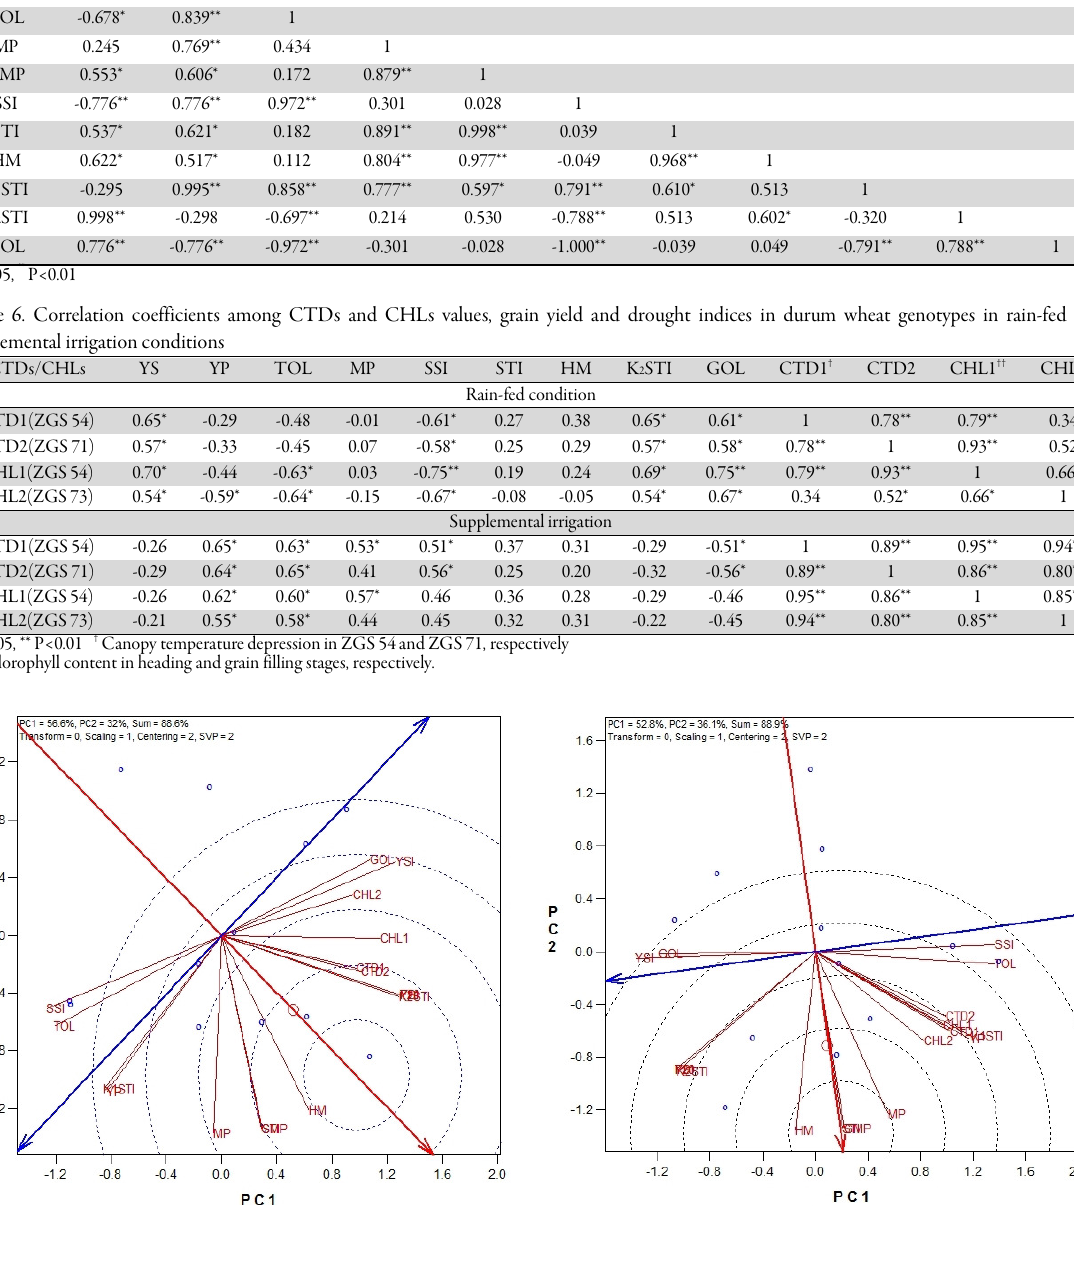
Fig. 2. Biplot of principal component analysis of physiological traits, grain yield and drought tolerance indices in supplemental irrigation